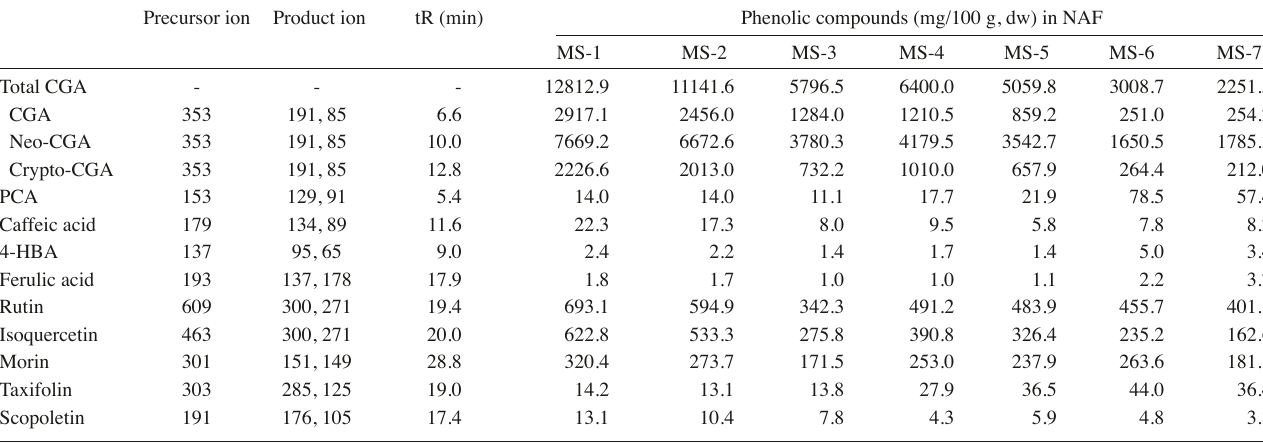
Tab. 2: Phenolic compounds in nonanthocyanin fractions (NAF) from mulberry fruits, measured by LC-MS/MS Precursor ion Product ion